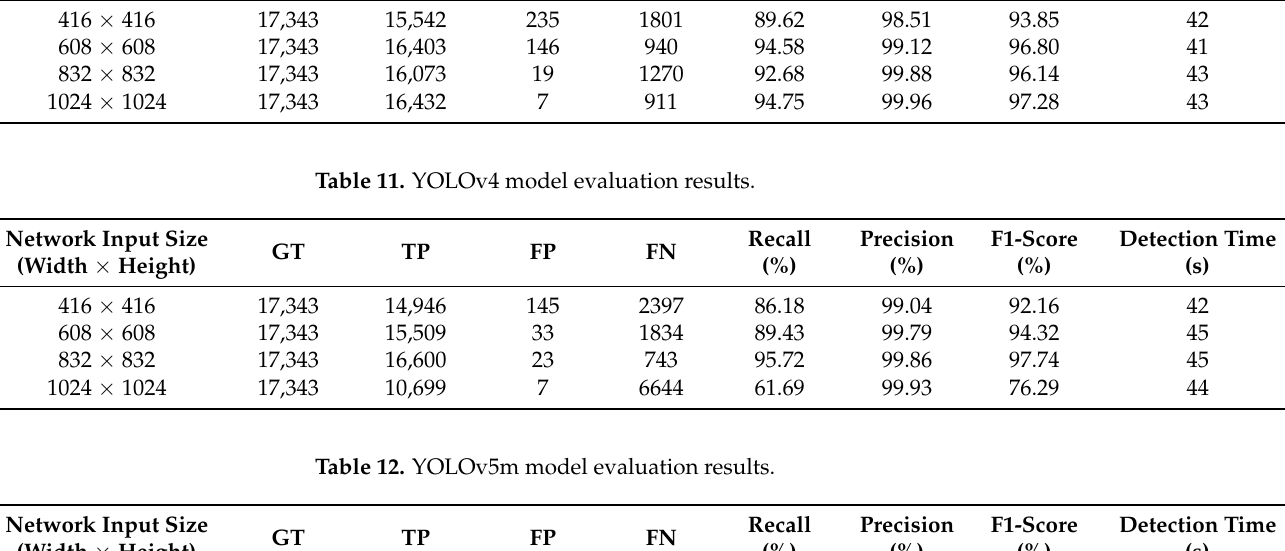
Table 12. YOLOv5m model evaluation results.